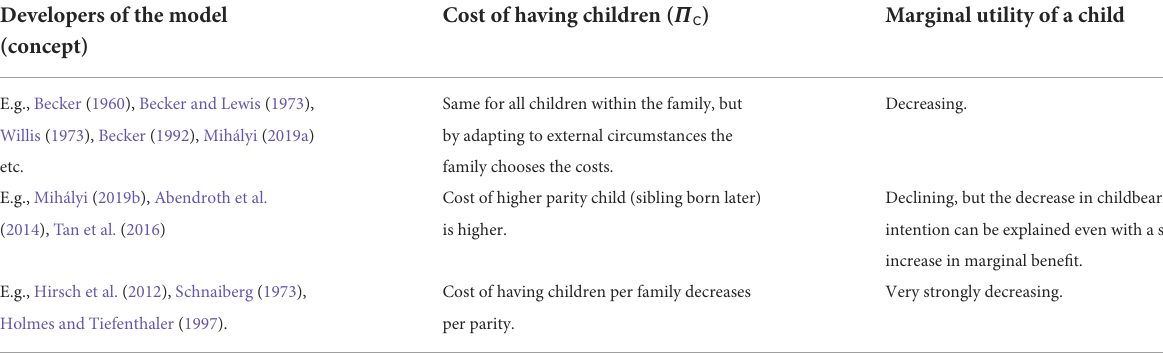
TABLE 1 Conditions for a decrease in the propensity to have children according to different model